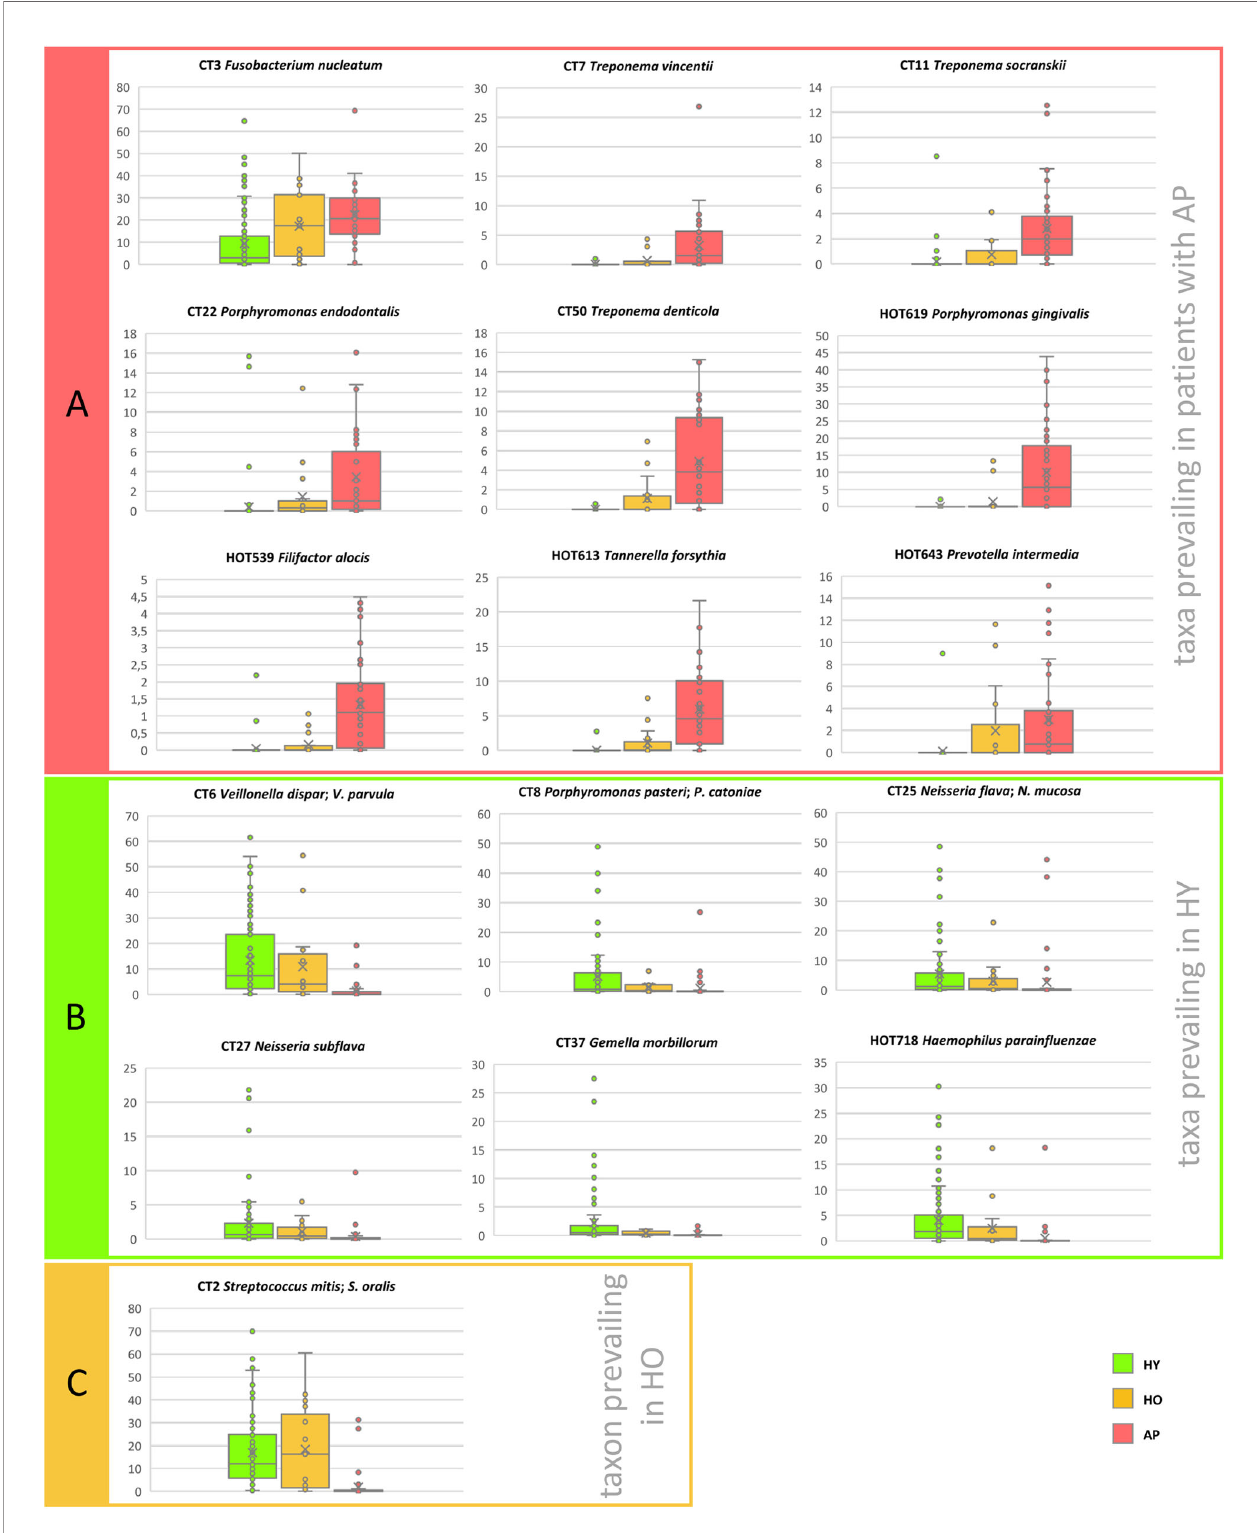
FIGURE 2 | The distribution of the relative abundances of selected taxa in relation to the age of probands and their state of health. (A) Taxa prevailing in periodontitis, (B) Taxa prevailing in HY, (C) Taxon prevailing in HO. The area of box plots with oral taxa dominant in patients with AP is highlighted in red, HY in green and one boxplot related to taxon most abundant in the HO group is highlighted in yellow. CT stands for combined taxon (See Supplementary Table 3